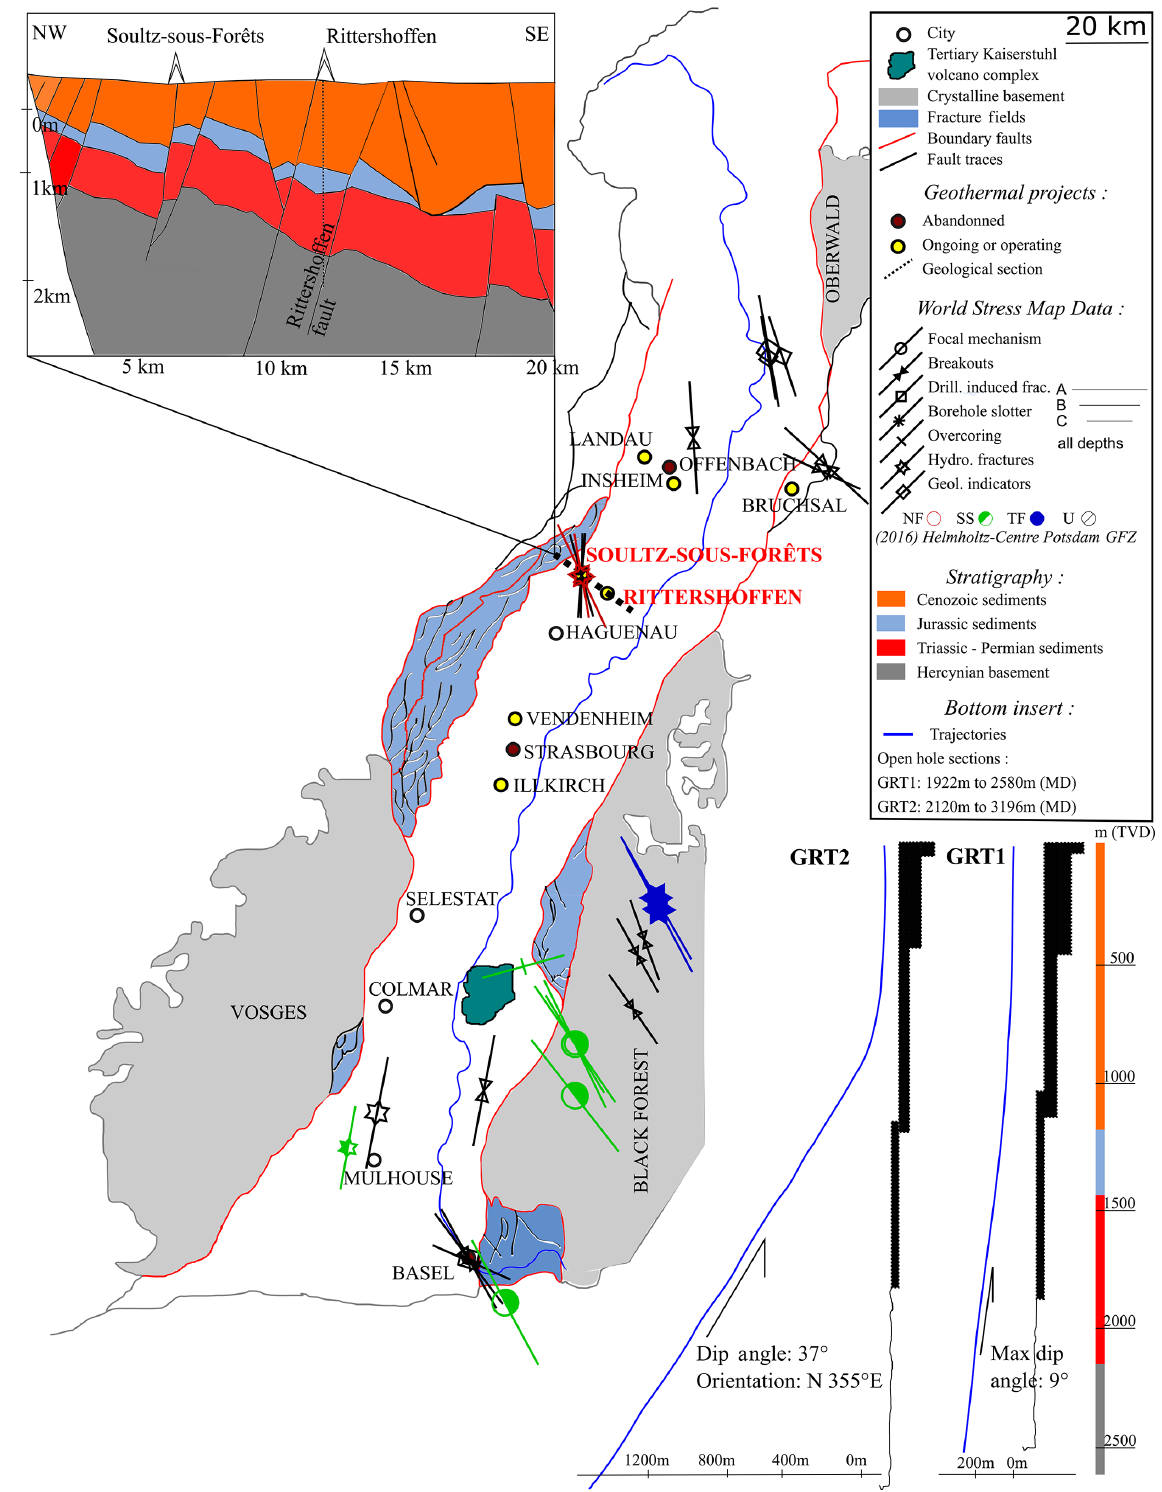
Figure 1. Geological and structural map of the main Upper Rhine Graben with the location of the Rittershoffen and Soultz-sous-Forêts sites. The map also shows the location and status of other neighboring deep geothermal projects. It includes stress data from the World Stress Map database (Heidbach et al., 2016). The upper left insert shows a geological section highlighting the main units crossed by the wells in Rittershoffen and Soultz-sous-Forêts (Aichholzer et al., 2016; Baujard et al., 2017). The lower right insert is a sketch of wells GRT-1 and GRT-2 drilled in Rittershoffen, which includes their geometry, depths and crossed lithology (after Baujard et al., 2015, 2017).